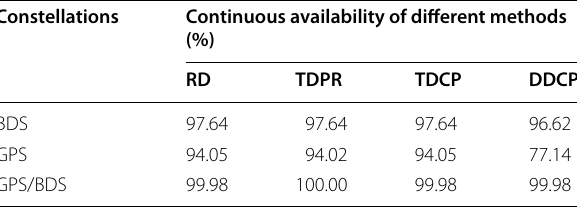
Table 4 The continuous availability in the dynamic test 2 Constellations